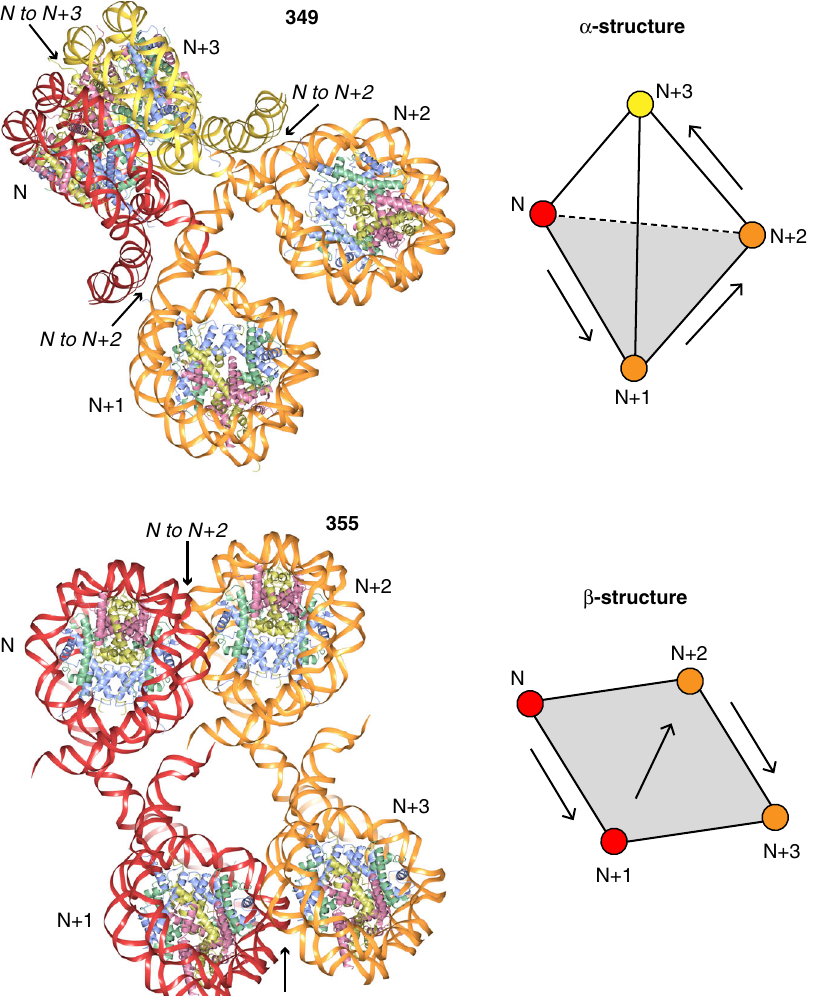
Fig. 7 Agreement between nucleosome fi bre structures and nucleosomal proximity mapping studies of chromatin. Four-nucleosome sections of the 349 and 355 fi bres are shown on the left, with the double helix coloured by dinucleosome repeat (as shown in Fig. 2). Nucleosome-nucleosome proximity relationships (primarily N to N + 2, secondarily N to N + 3) found to be enriched in chromatin mapping studies 19,24,29 are indicated. On the right, for comparison, is a schematic representation of the folding motifs found in yeast chromatin 24